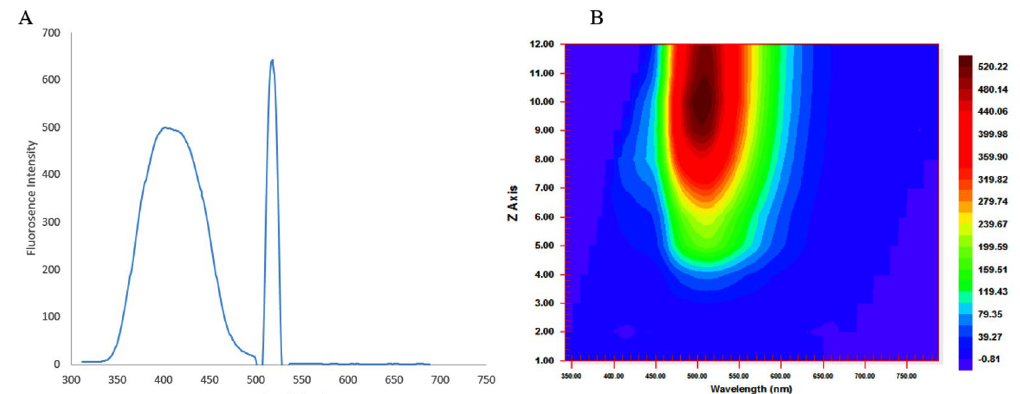
Fig. 5. (A) Shows the fluorescence spectral features of the partially purified fluorescent compound from Penicillium sp. MIP-3 (B) Contour graph showing the emission